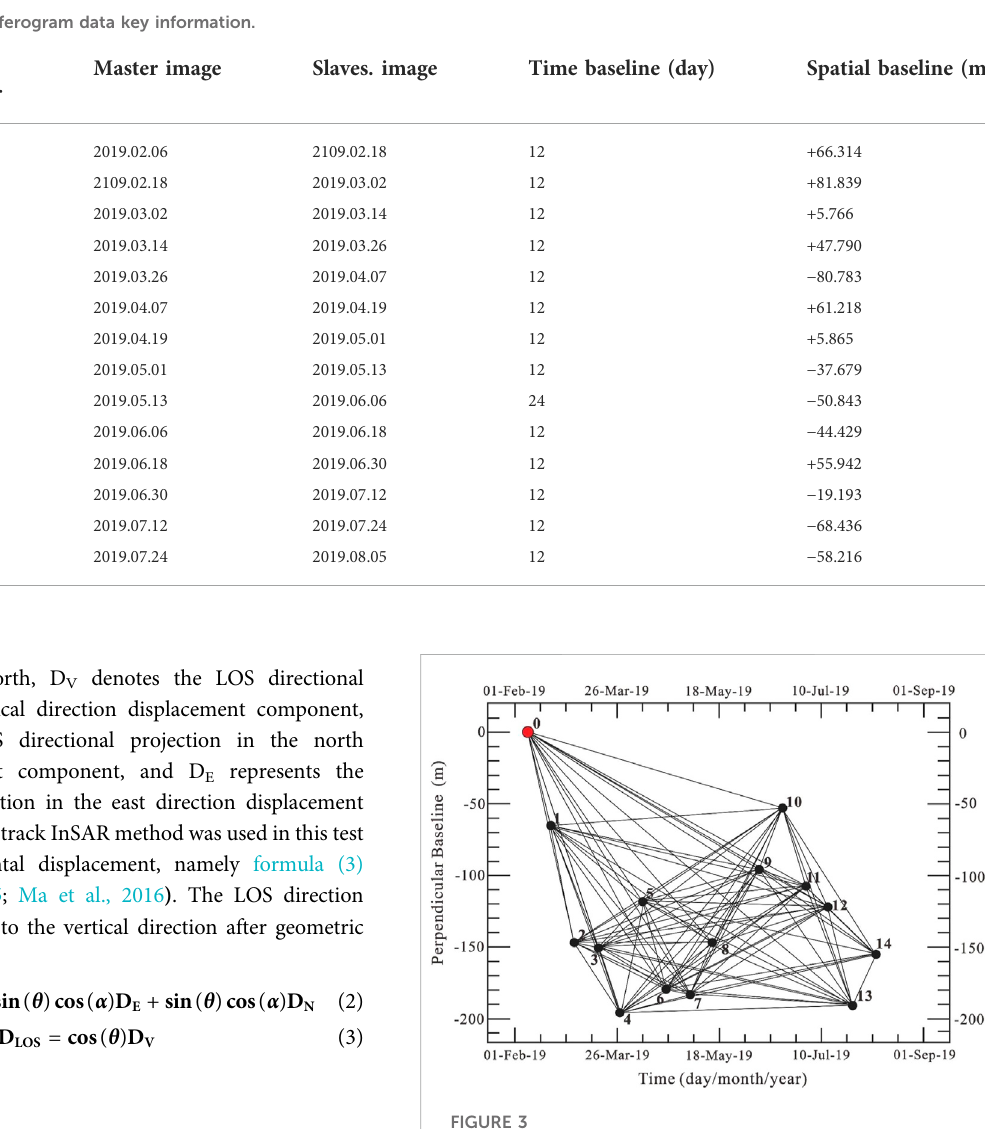
FIGURE 3 SBAS-InSAR connection